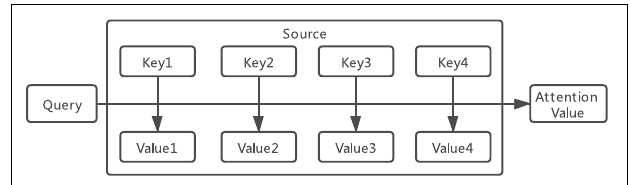
FIGURE 3 | Attention principle architecture.